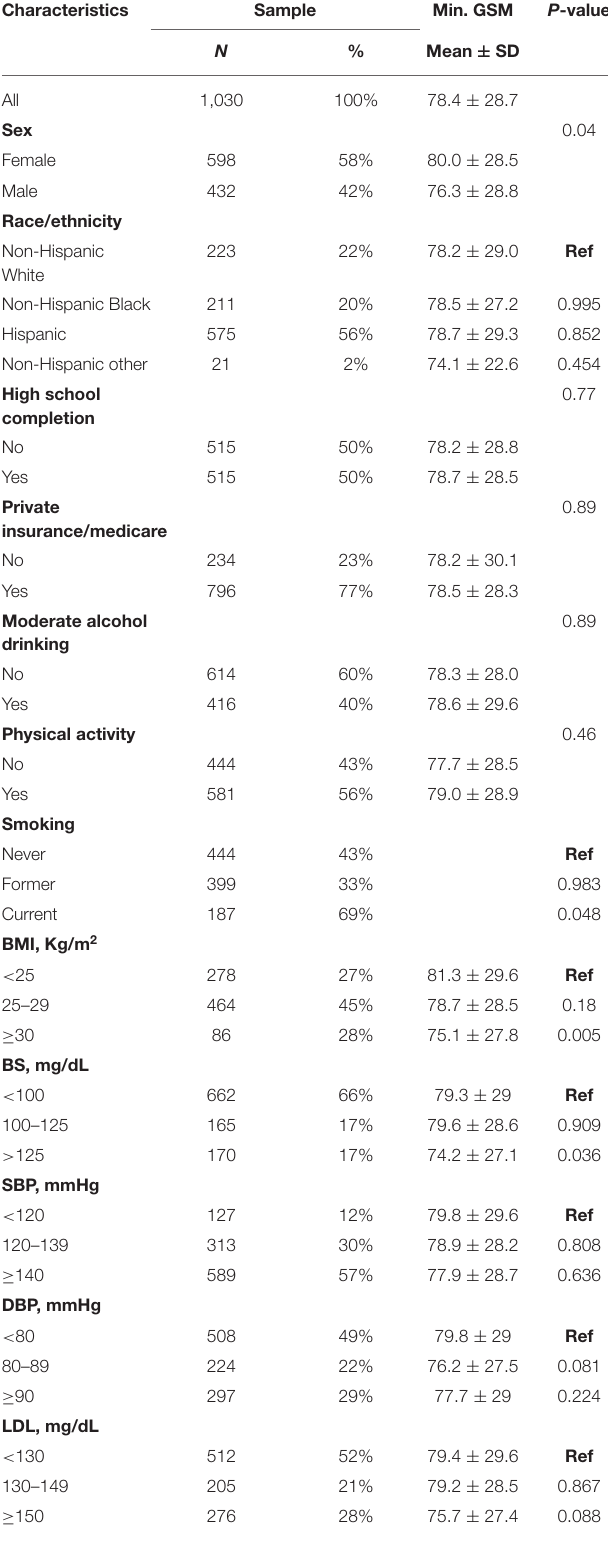
TABLE 1 | Demographic and clinical characteristic of study